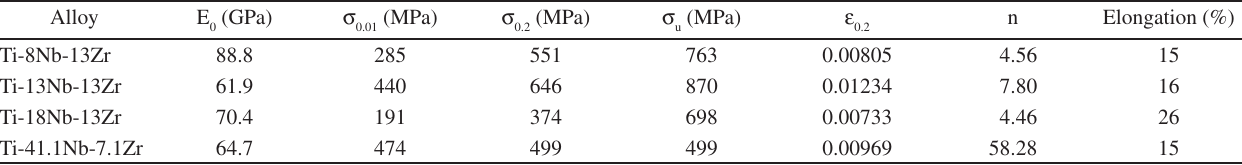
Table 2. Mechanical properties of the Ti-Nb-Zr alloys.